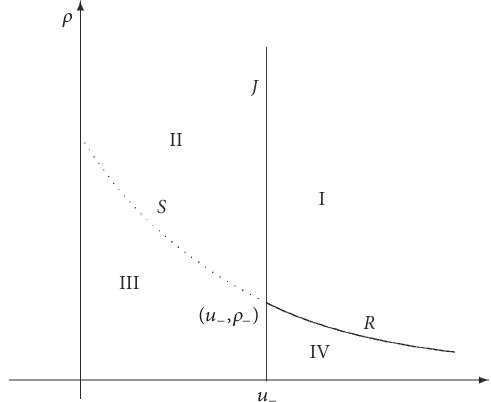
Figure 1: Wave curves in the phase plane ( 𝑢 , 𝜌